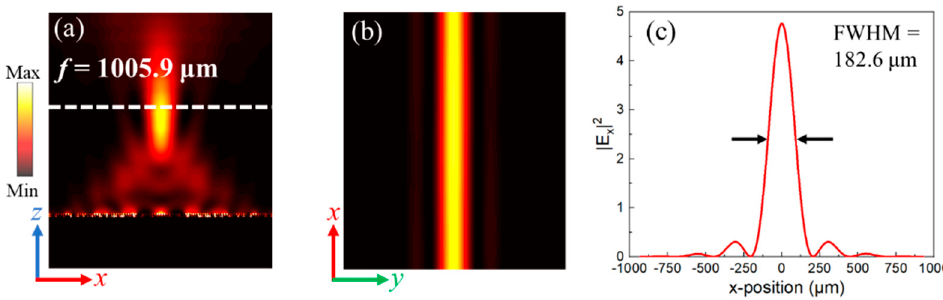
Figure 7. The electrical field distributions of cross-polarized waves | E x | 2 in ( a ) x - z plane and ( b ) x - y plane. ( c ) The profile of | E x | 2 in focal plane.